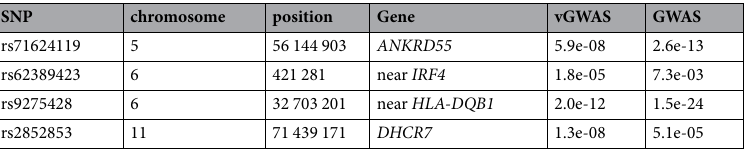
Table 2. vGWAS signals identified in the combined data and their corresponding GWAS